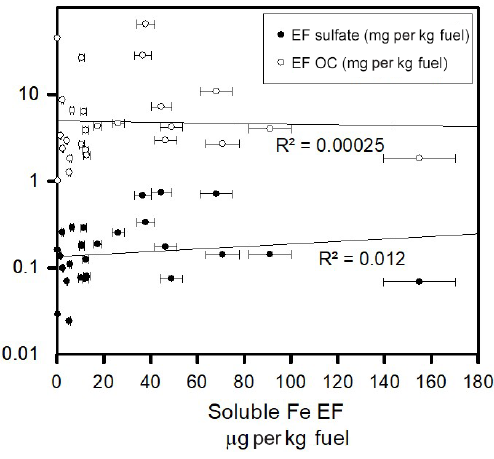
Figure 4. Fe valence scatter plot generated from Fe K-edge XANES data; κ and µ are normalized absorbance values at 7113 and 7117.5eV, respectively. Empty black squares represent Fe standards of known valence, while blue-filled stars represent vehicle exhaust